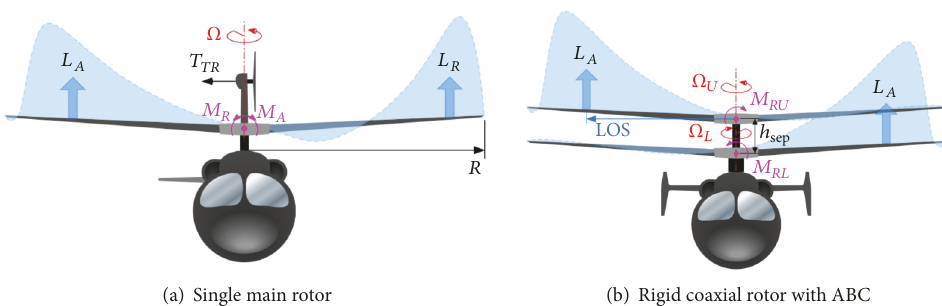
Figure 1: XH-59A technical demonstrator.